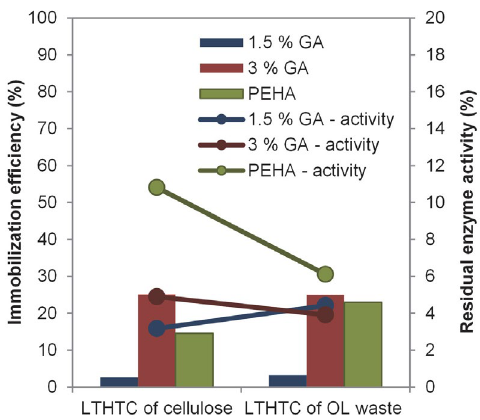
Figure 3. Influence of pH on immobilization efficiency and residual enzyme activity. Reaction conditions: 5 mg of chosen biochar, en- zyme concentration of 2.3 mg/mL, crosslinker PEHA, 7-h immobi- lization of enzyme with continuous stirring at 300 rpm, at ambient temperature and at atm. pressure. Standard deviation for all meas- urements was less than ±